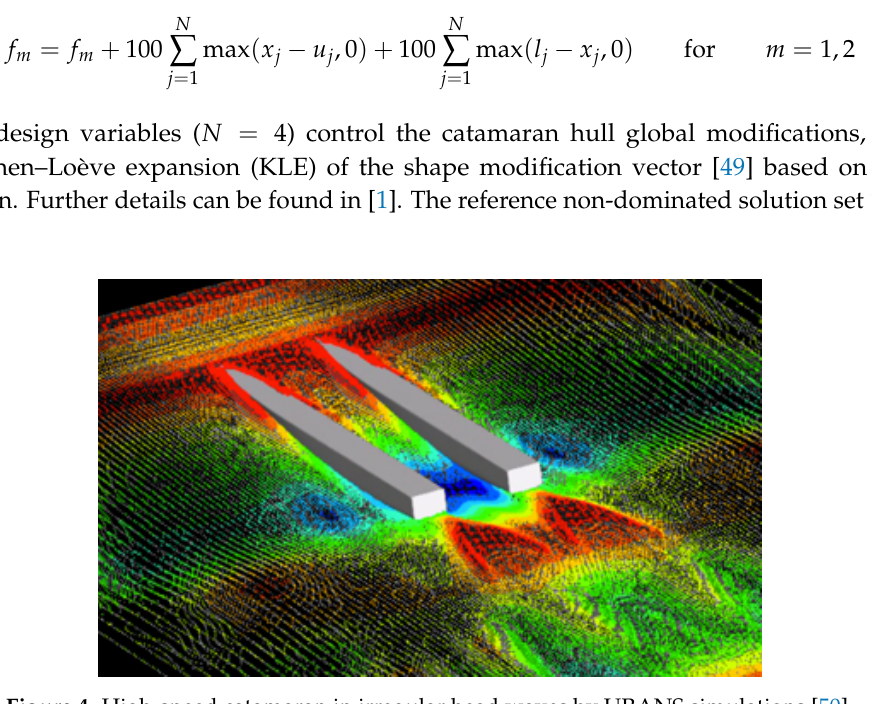
Figure 4. High-speed catamaran in irregular head waves by URANS simulations